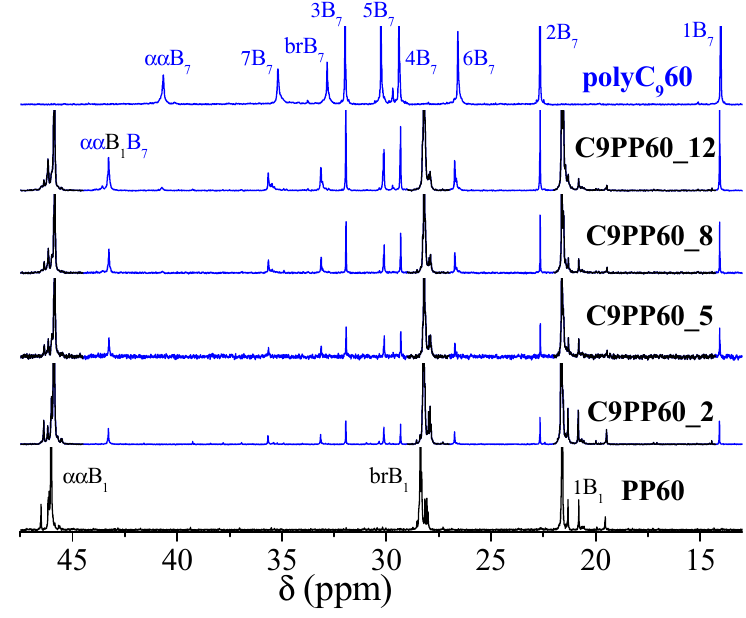
Figure 1. 13 C NMR spectra for the samples obtained at 60 ° C.